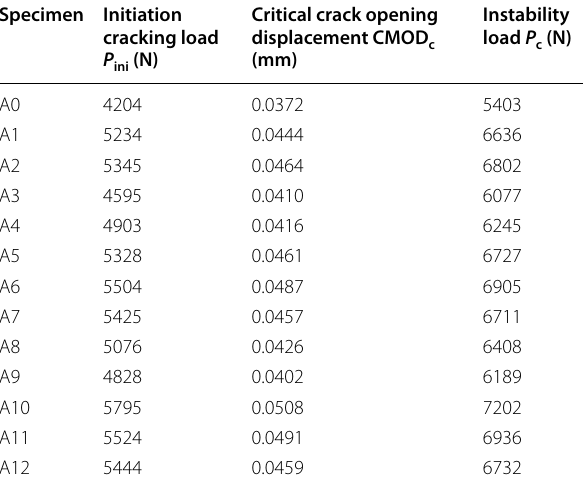
of each group c